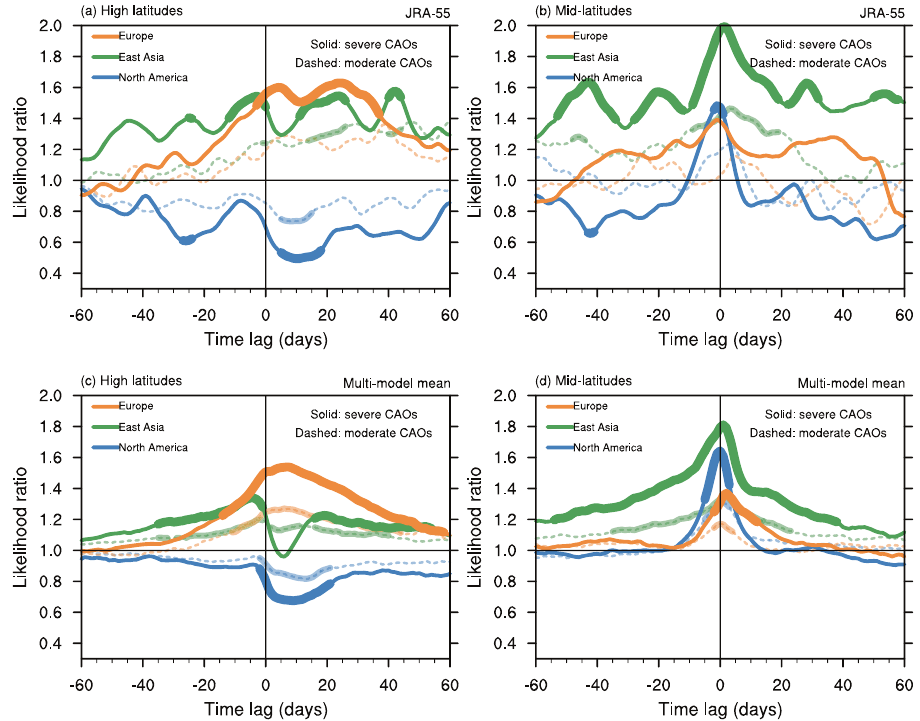
Fig. 2 The time-lagged likelihood of CAOs under weak polar vortex conditions. a The likelihood of severe CAOs (solid lines) and moderate CAOs (dashed lines) in high latitudes under weak polar vortex conditions as a function of the lag between the polar vortex state and the CAOs for the reanalysis data. For instance, a lag of 20 days indicates that the likelihood of CAOs is conditional upon the weak polar vortex 20 days before (see Methods). Shown is a 5-day running mean of the likelihood of CAOs to remove the noise in the reanalysis data. Note that the main conclusions are not sensitive to the smoothing. The blue, orange, and green curves respectively represent North America, Europe, and East Asia. b As shown in ( a ), but for mid-latitude regions. c , d As shown in ( a ) and ( b ), respectively, but for the results of the multi-model mean. The thick line segments indicate that both the likelihood of CAOs and their difference between severe and moderate CAOs are statistically signi fi cant at a 95% con fi dence level. The signi fi cance is estimated by the bootstrap resampling method of repeating 1000-time random selections with